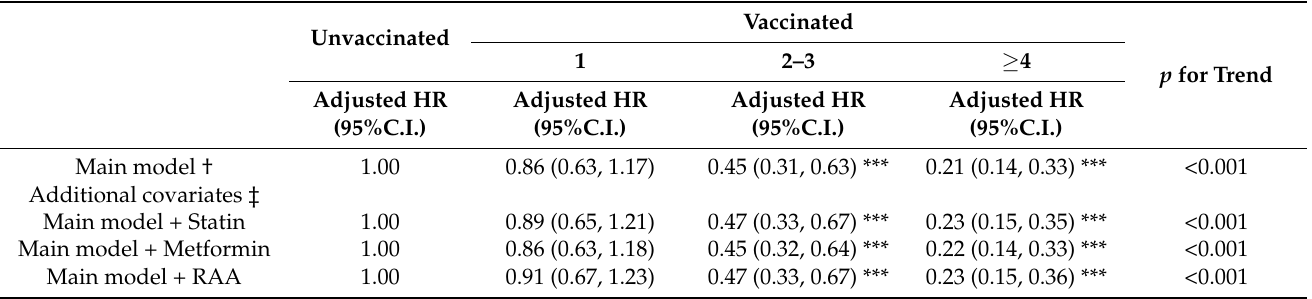
Table 3. Sensitivity analysis of adjusted HRs of vaccination in risk reduction of liver cancer in whole